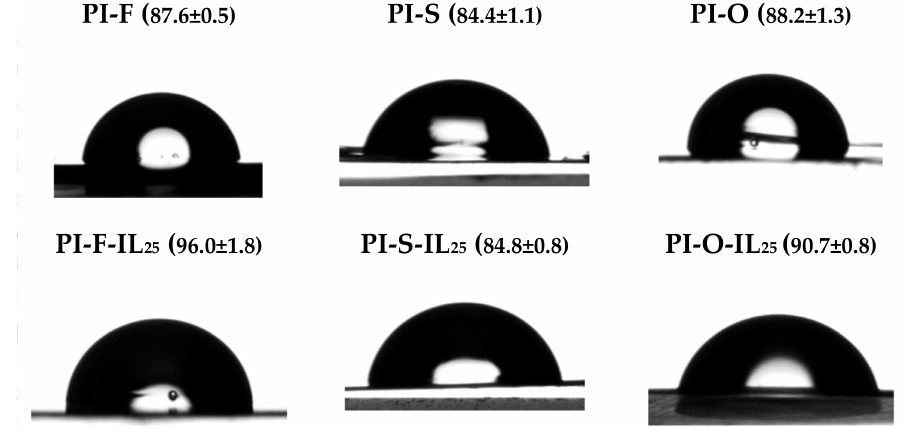
Figure 7. The profiles of a water droplet on the tested